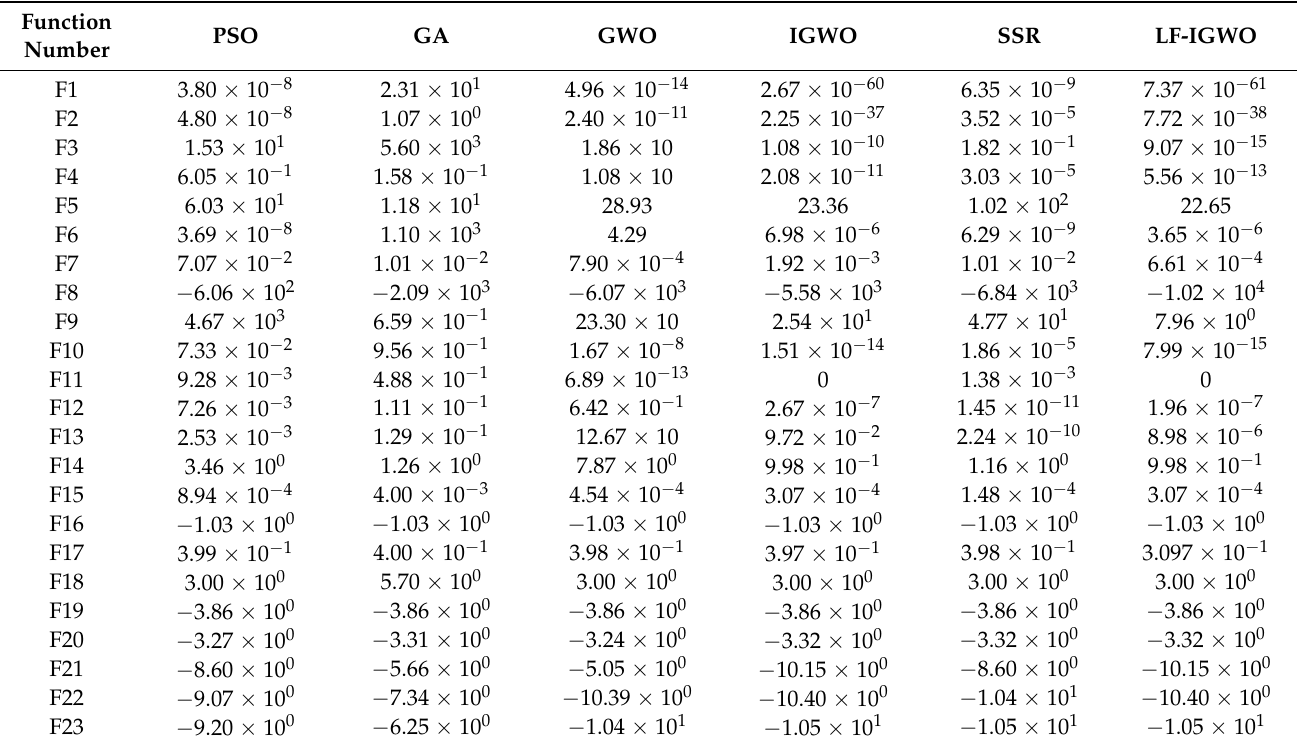
Table 6. Comparison of mean values obtained from classical benchmark